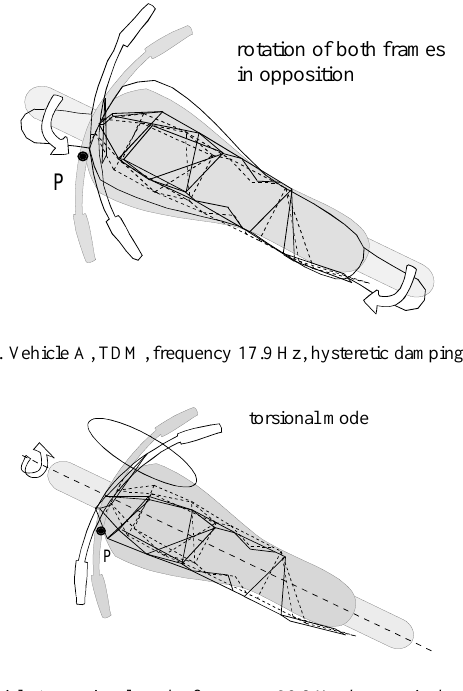
Fig. 8. Vehicle A, torsional mode, frequency 26.8 Hz, hysteretic damping